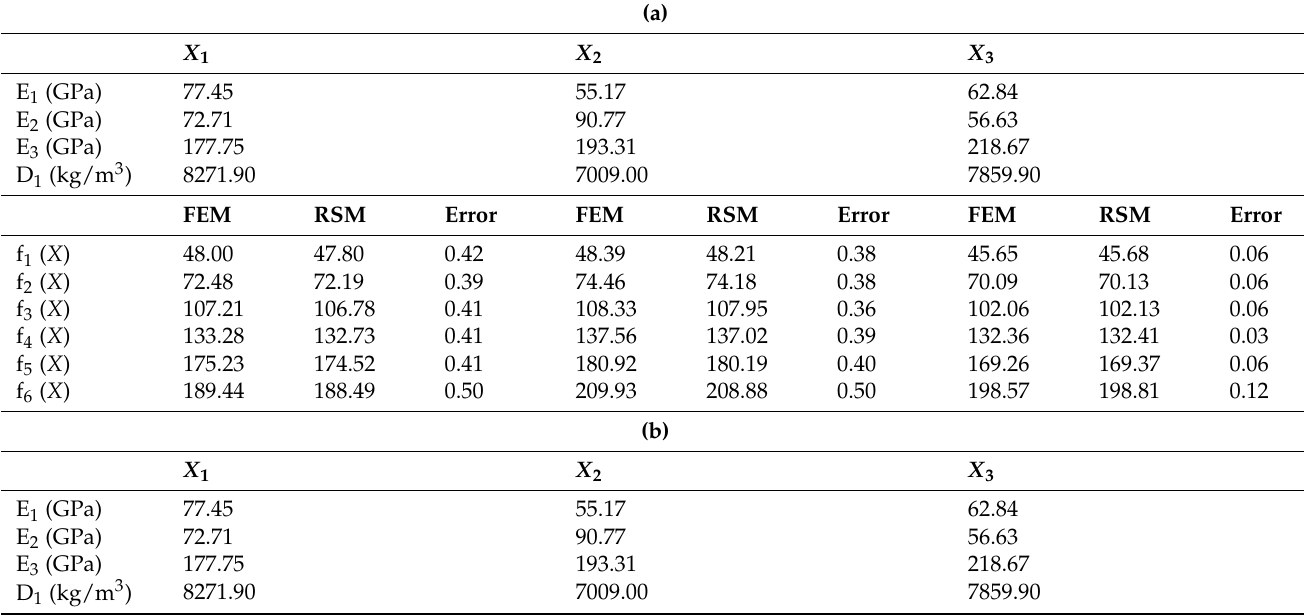
Table A2. ( a ). Relative errors of objective function values between RSM and solid FE model. ( b ). Rel- ative errors of objective function values between RSM and mixed